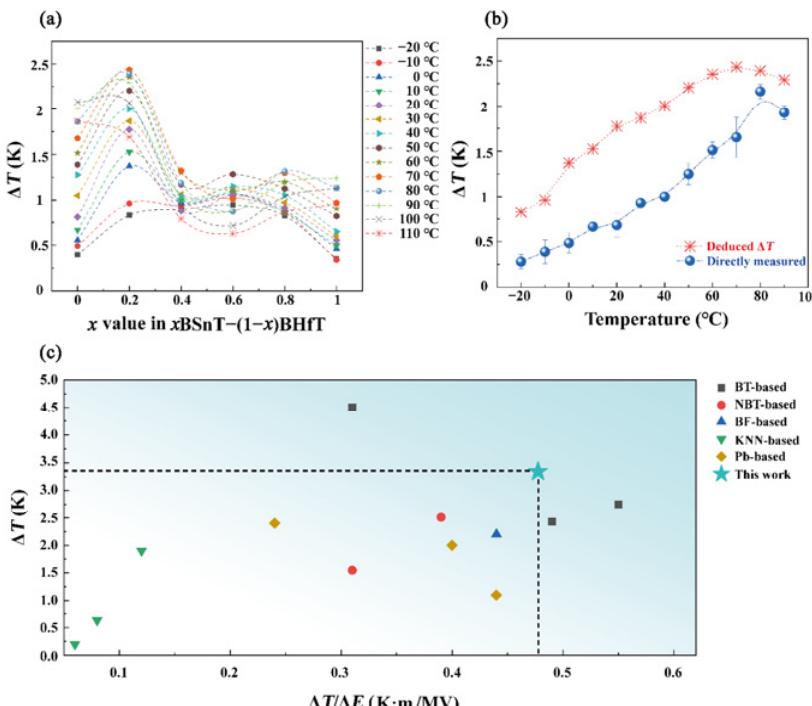
Fig. 5 (a) Indirectly calculated ECE results for x BSnT–(1 − x )BHfT ceramics at 5 MV/m based on Landau–Devonshire phenomenological theory, where  coefficients were deduced via the modified Curie–Weiss law and the dielectric constant as a function of temperature and frequency presented in Fig. 2(a). (b) Directly (blue color) and indirectly (red color) obtained ECE as a function of temperature from − 20 to 90 ℃ at 5 MV/m for x = 0.2 ceramic. (c) Comparison of ECE T  and  T /  E for various